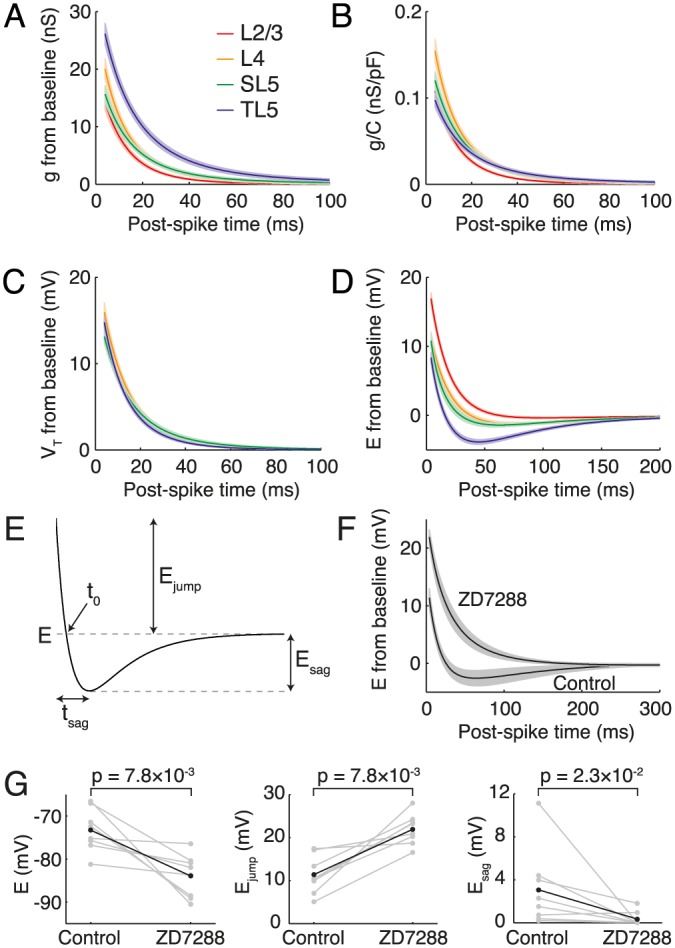
Class-dependent post-spike dynamics of A conductance g, B
g/C = 1/τ, C spike threshold V
T and D equilibrium potential E. Note the sag in the E dynamics of TL5 cells. E Quantifying E dynamics by jump and sag depth. F TL5 E dynamics in control conditions and after application of I
h-blocker ZD7288, which abolished the sag. G The blocker also resulted in a hyperpolarization of the steady-state rest, with a post-spike jump increase and sag-depth reduction.